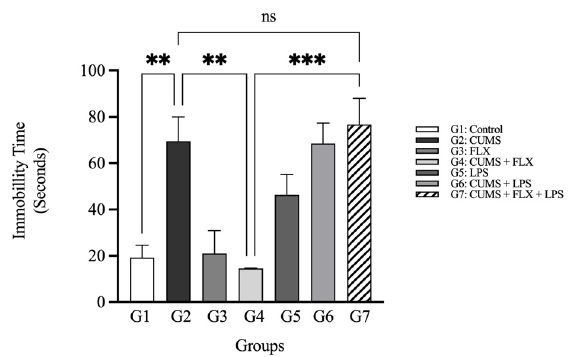
Figure 6. Effect of Lipopolysaccharide on Latency and Duration of Immobility in Fluoxetine Treatment Resistant Depressive Rats Exposed to Forced Swimming Test (Seconds): Data are expressed as the means ± SEM; n = 5. Group comparisons were performed using one-way ANOVA followed by a Turkey – Kramer post hoc test; ** p < 0.01; *** p < 0.001. CUMS: chronic unpredictable mild stress; FLX: fluoxetine; LPS: lipopolysaccharide; ns: non-significant.